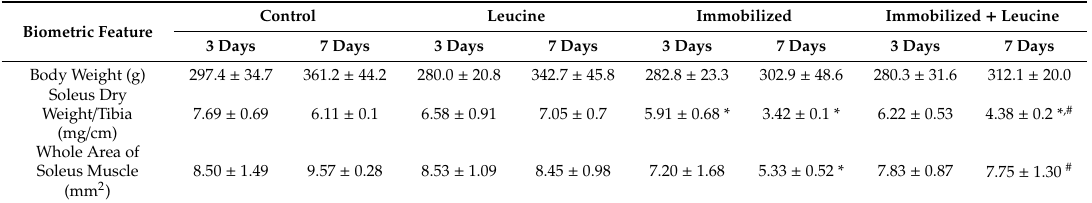
Table 1. Body and muscle measurements analysis after 3 and 7 days of immobilization and leucine supplementation. Data were expressed as Mean ± SD. Statistical analysis included one-way ANOVA followed by Tukey’s posthoc ( n = 6–7 per group, two independent experiment were performed). * p < 0.05 vs. Control Group; # p < 0.05 vs. Immobilized